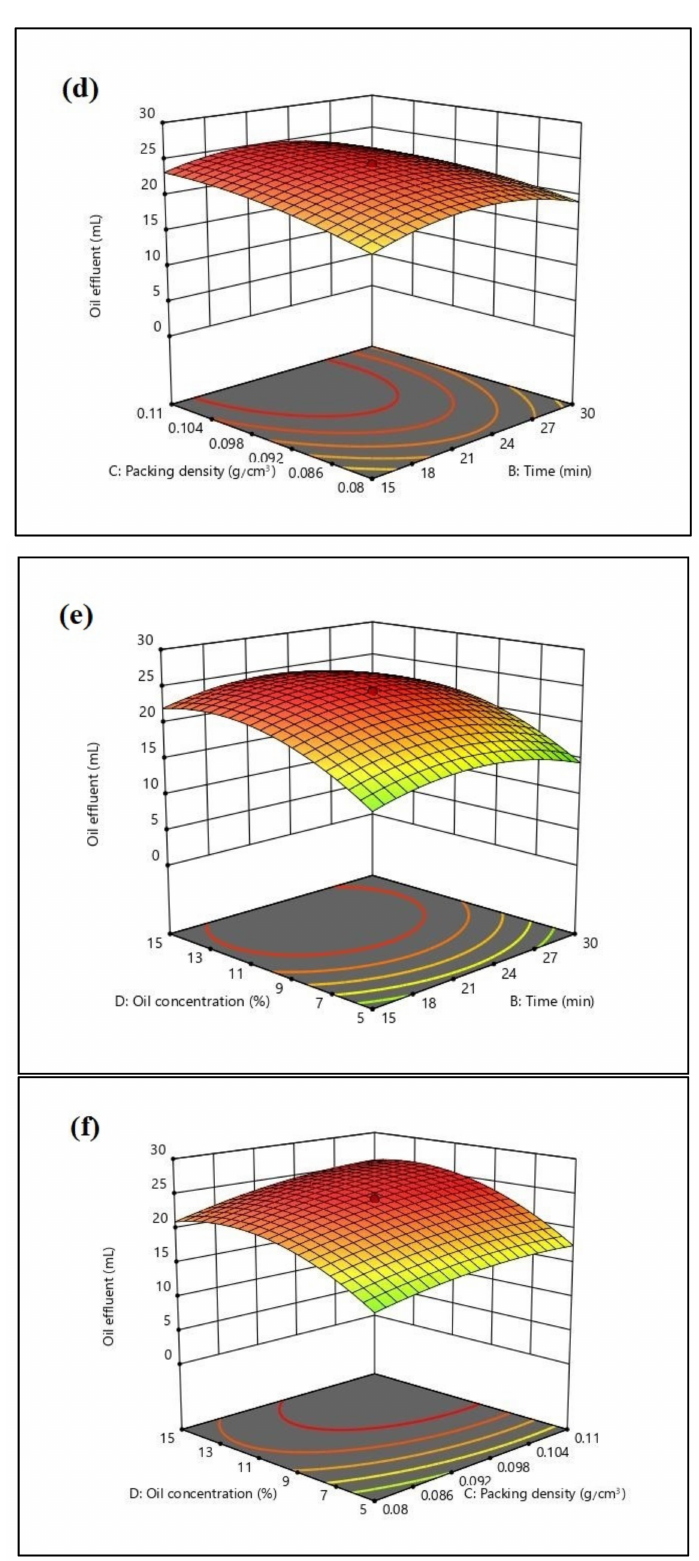
Figure 9. 3D Contour plots generated by Design Expert (Stat Ease, Inc., Minneapolis, USA) of the significantly interacting model terms: ( a ) A: temperature and B: time, ( b ) C: packing density and A: temperature, ( c ) D: oil concentration and A: temperature, ( d ) C: packing density and B: time, ( e ) D: oil concentration and B: time, and ( f ) D: oil concentration and C: packing